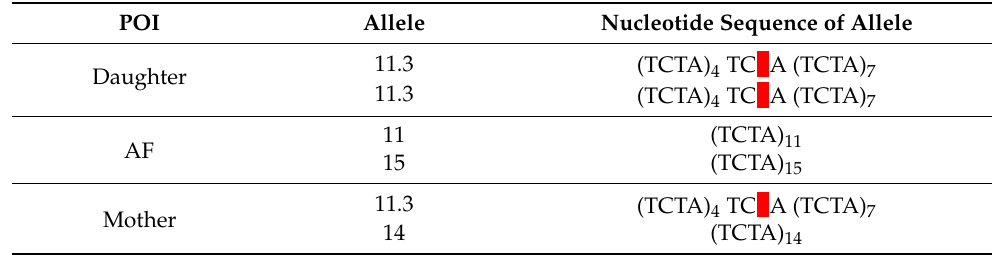
Table 3. Allele nucleotide sequences of marker D2S441 with highlighted single nucleotide deletion.